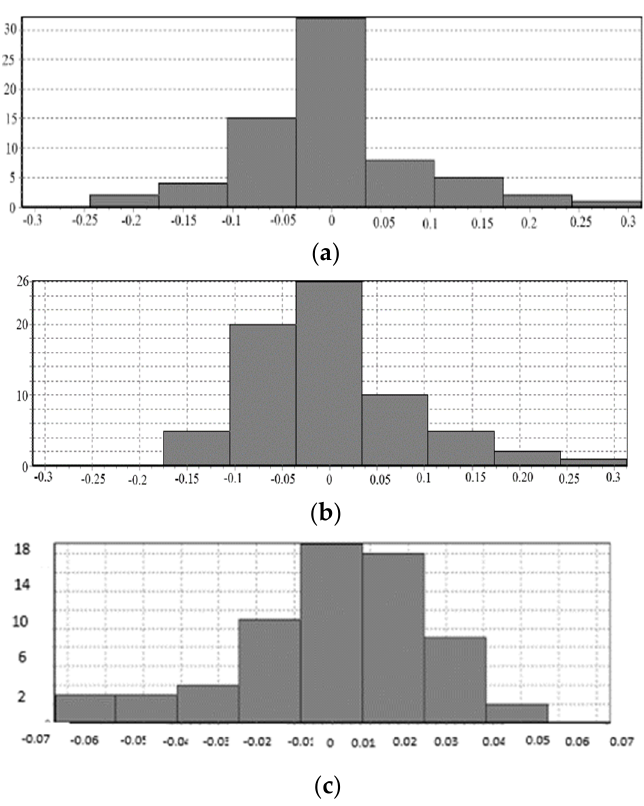
Figure A1. Histogram of residuals: ( a ) y 1 ; ( b ) y 2 ; ( c ) y 3 . The normal probability plot for motor efficiency ( y 3 ) is shown on Figure A2.